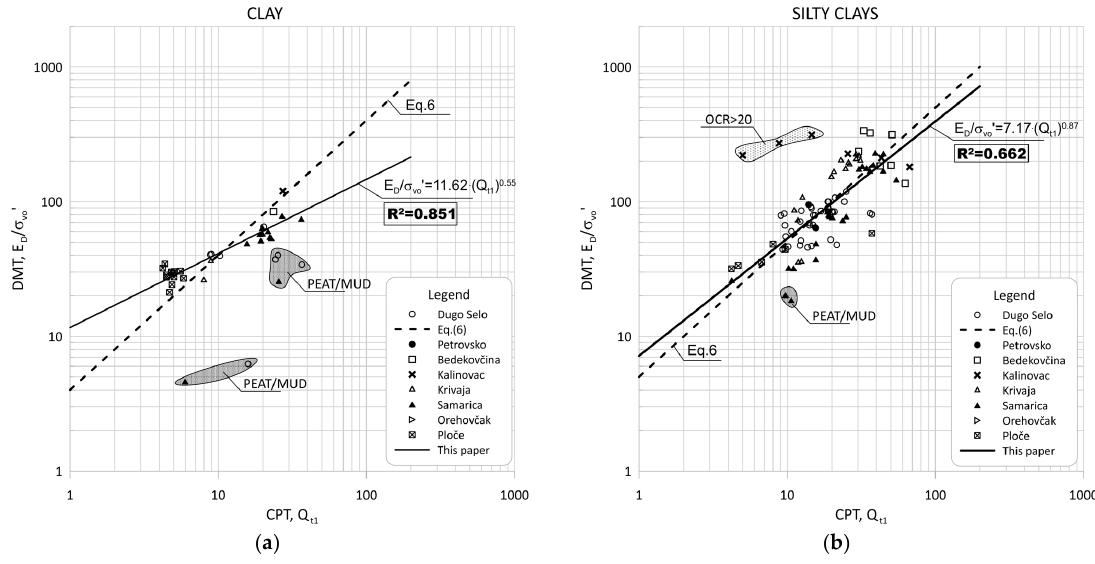
versus < 0.6, > 2.95). 𝑄𝑄 𝑡𝑡1 𝐸𝐸 𝐷𝐷 𝜎𝜎′ 𝑣𝑣0 ⁄ 𝐼𝐼 𝐷𝐷 𝐼𝐼 𝑐𝑐